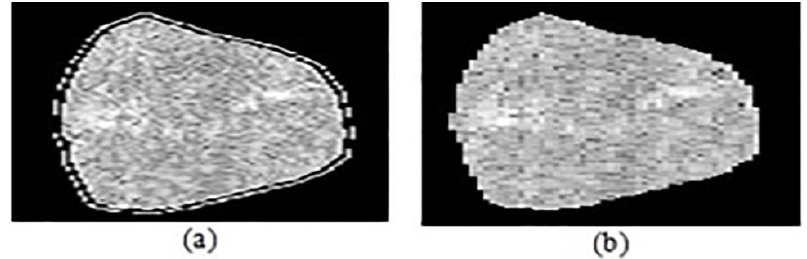
Figure 4. ( a ) Radiologist outlining; ( b ) computerized segmentation.